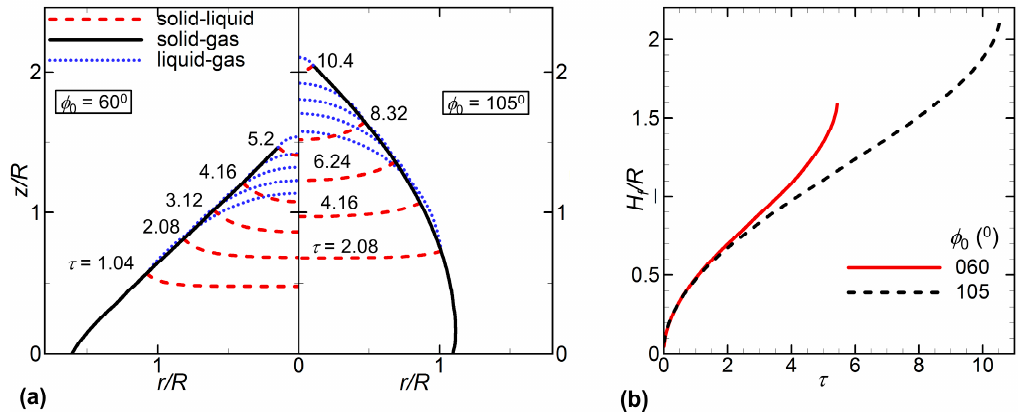
Figure 5. Effect of the contact angle on the solidification process for two cases φ 0 = 60° and 105°: ( a ) the evolution of the solidifying front and ( b ) the average height H f of the solidifying front. Other parameters: ρ sl = 0.9 and φ gr = 12°.